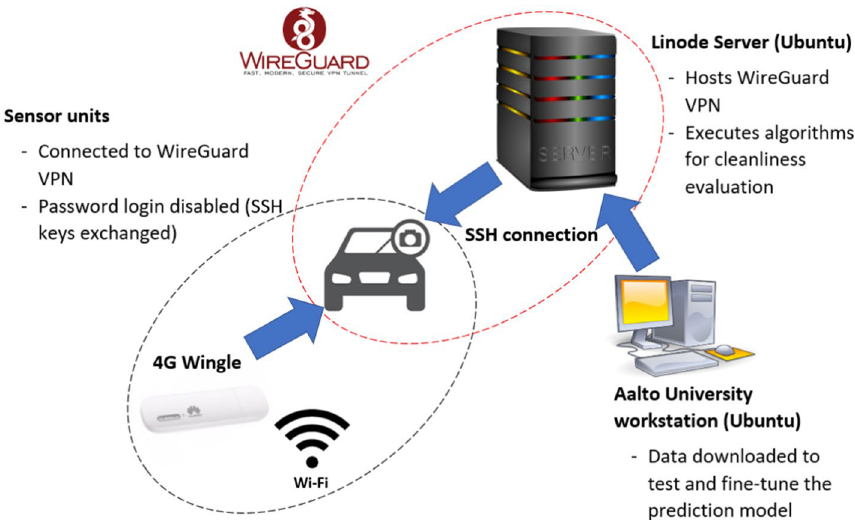
Fig. 12 Communication setup of the detection